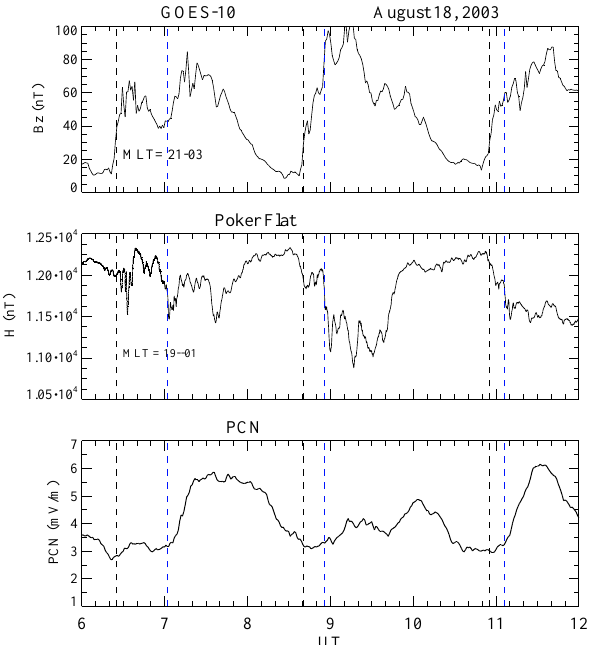
Figure 6. Panels from top to bottom show the GOES-10 B z com- ponent (nT), Poker Flat H -component deflection (nT), and the PCN index (mVm − 1 ). Vertical dashed guidelines corresponding to pseudo-breakups (black) and major local onsets (blue) for each of the three sawtooth substorm are shown.